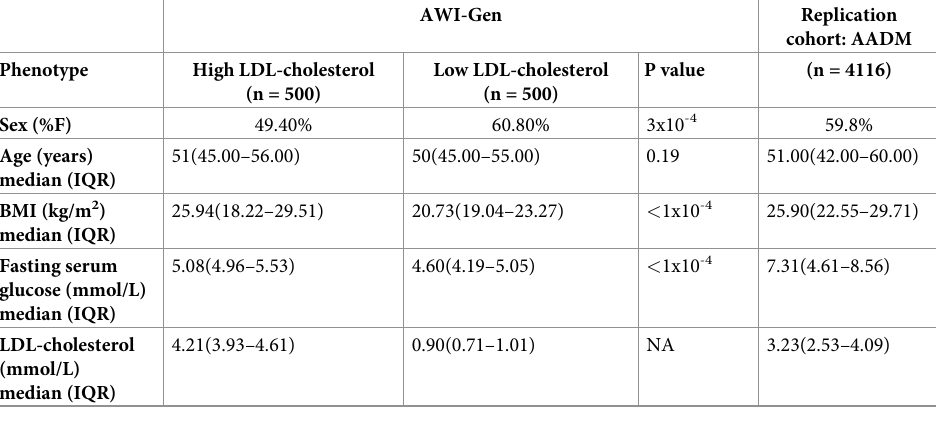
Table 1. Phenotype characterisation of 1000 AWI-Gen participants and 4116 AADM